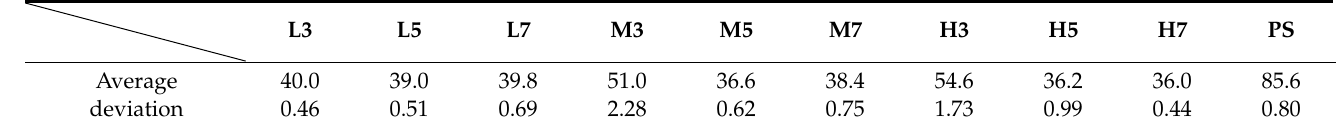
Figure 6. Schematic diagram of contact angle measurement. This is the contact angle between the polystyrene cell culture plate and the GO-coated polystyrene cell culture plate (the sample showing the best cell growth). The contact angle of PS was measured to be 85.6°, and that of H3 was measured to be 54.6°. Table 3. Water contact angles of the L, M, and H surfaces. (PS = polystyrene) The measurement results are expressed as average values after 5